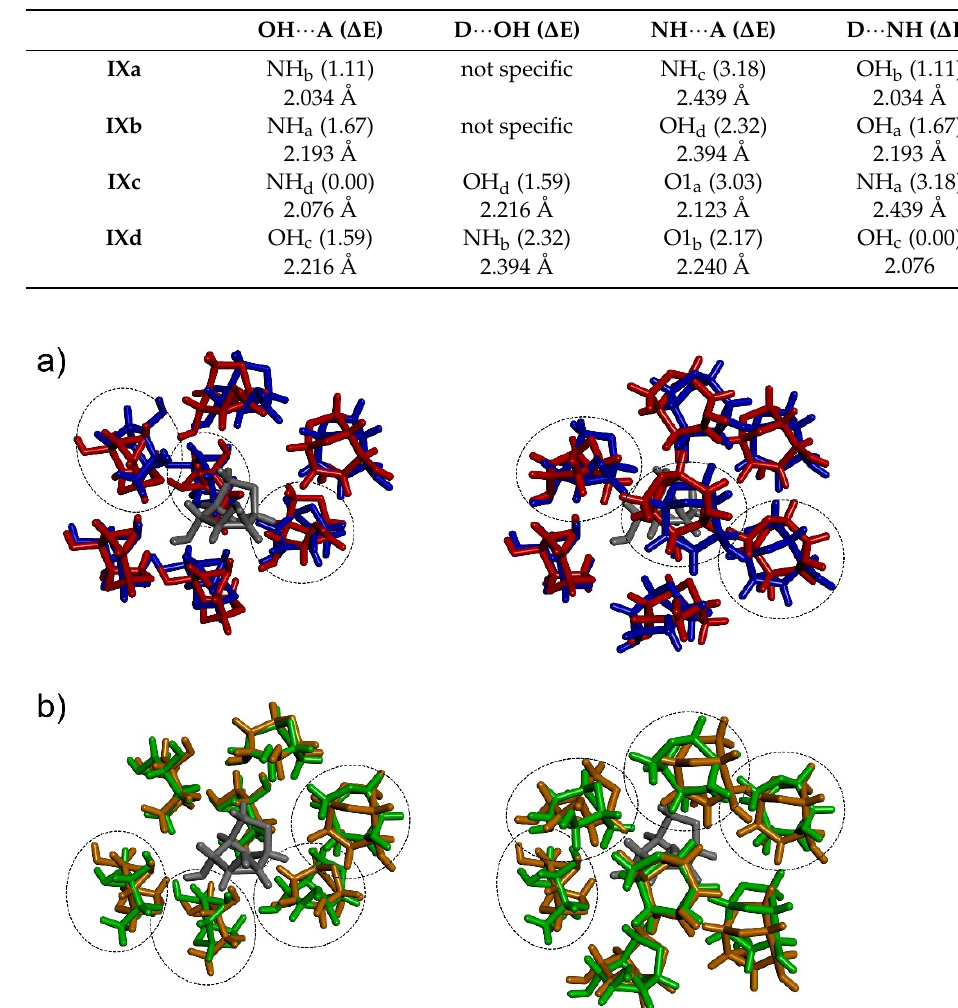
Figure 8. An overlay of the molecules surrounding IXa (blue) and IXb (red) parent molecule ( a ), and IXc (orange) and IXd (green) parent molecule ( b ); molecules in the back (left) and in the front (right). Parent molecules are depicted in gray. Dashed circles indicate the molecules mutually rotated by 180 ◦ with the switched OH and NH